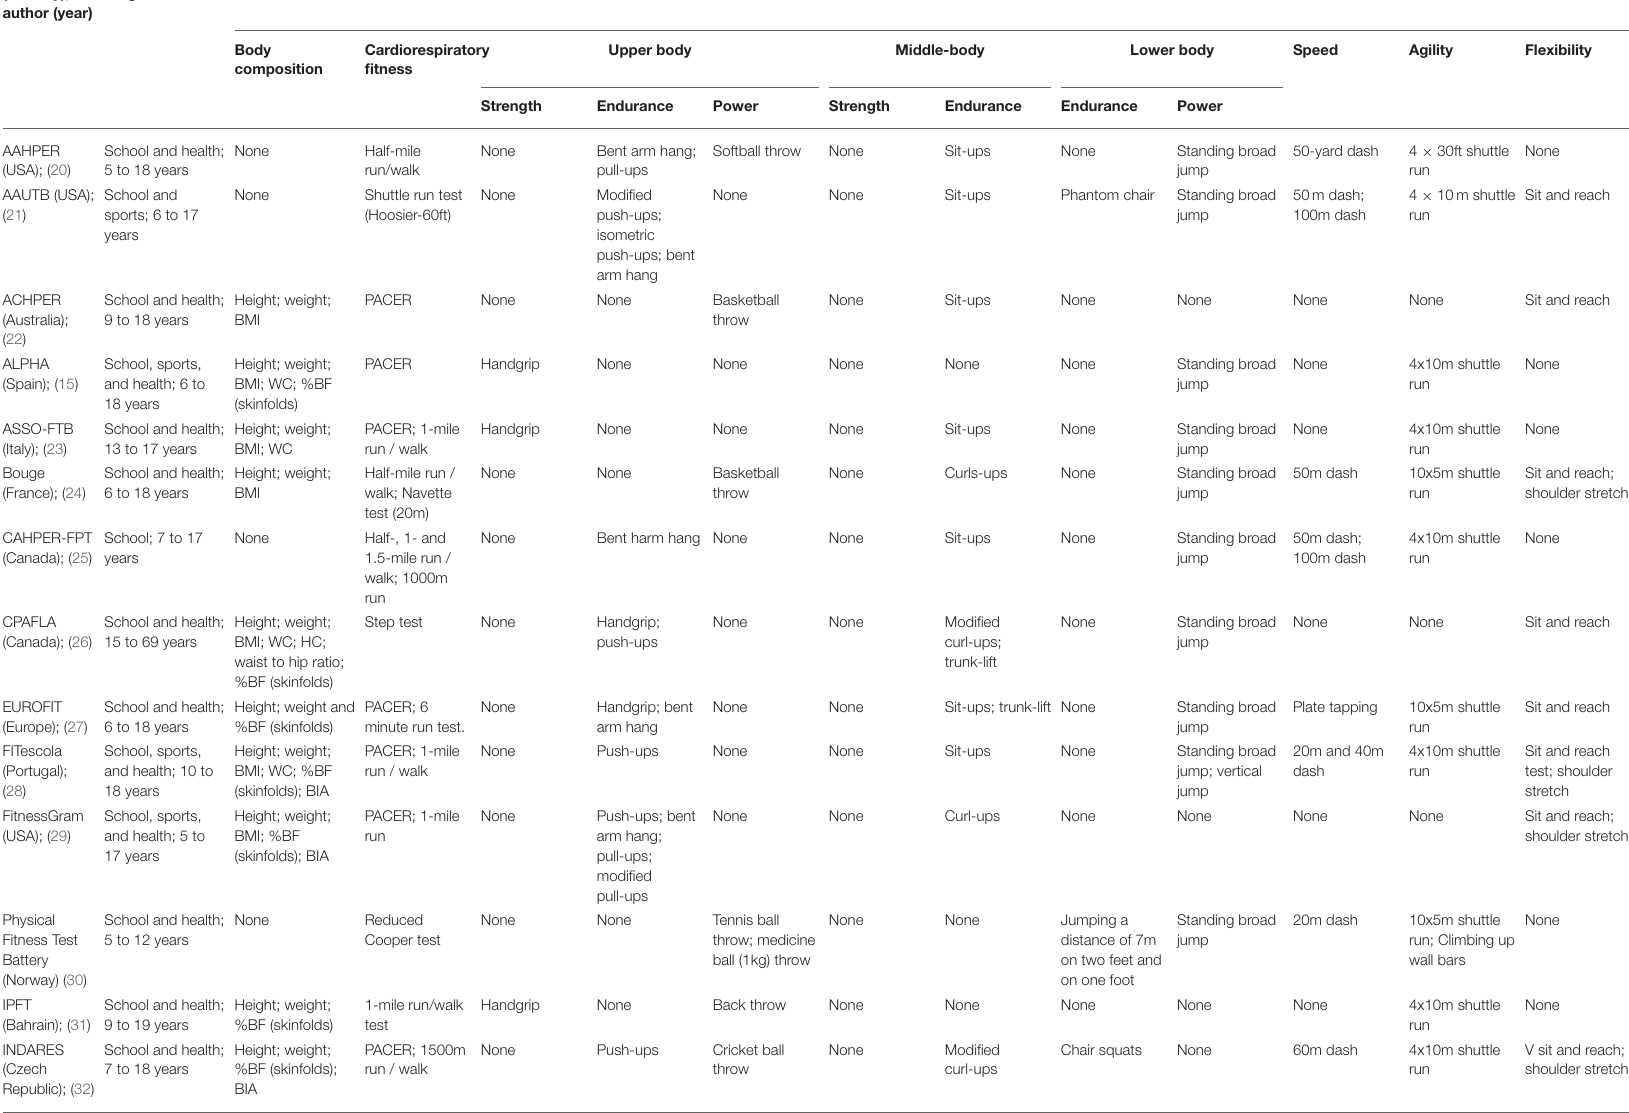
TABLE 1 | Presentation and summary of the physical fitness batteries identified in the included records.